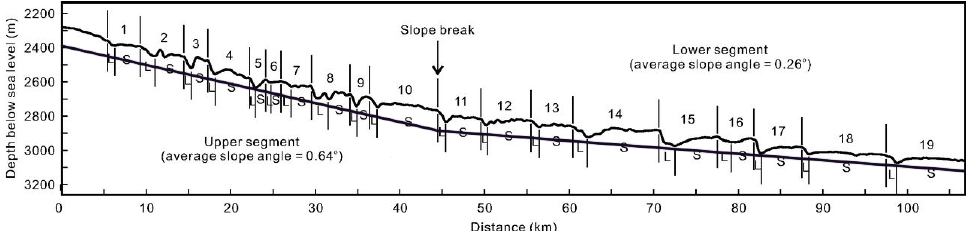
Figure 4. Cyclic steps within the South Taiwan Shoal canyon. Redrafted from Zhong et al. [9]. 1–10 cyclic steps are in the upper segment and 11–19 cyclic steps are in the lower segment; L indicates the lee sides and S indicates the stoss